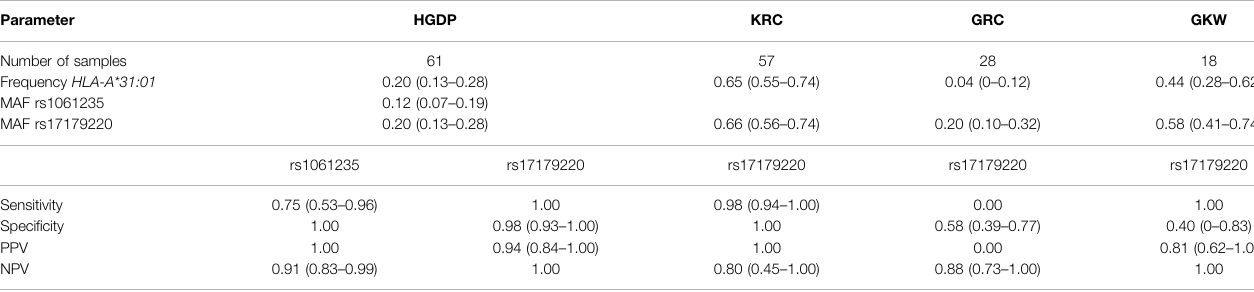
TABLE 2 | Predictive performance of rs1061235 and rs17179220 for tagging HLA-A*31:01 in Native American samples.